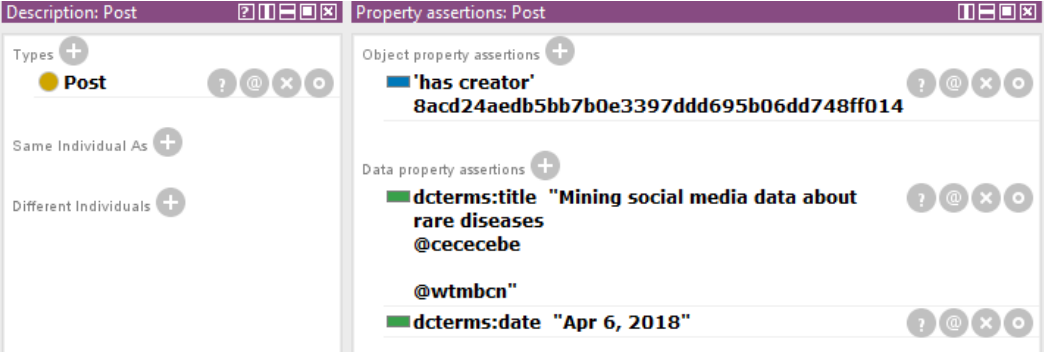
Figure 4. Anonymous representation of a post of a person interested on rare diseases in the proposed ontology. A SHA1 operation has been performed on the names of the people in order to preserve their